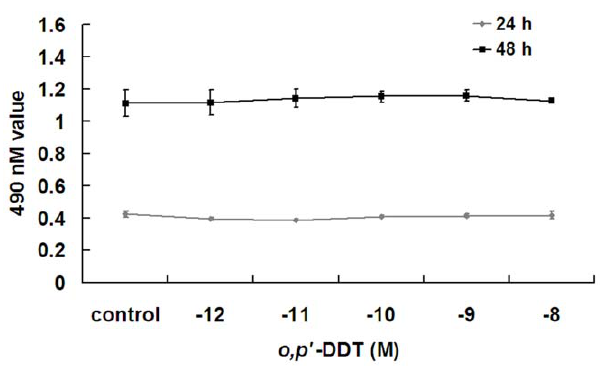
Figure 1. Low concentrations of o,p’ -DDT have no effects on cell viability of rat ovarian granulosa cells. Granulosa cells were exposed to o,p’ -DDT (10 2 12 to 10 2 8 M) for 24 h or 48 h and cell viability was measured using MTS